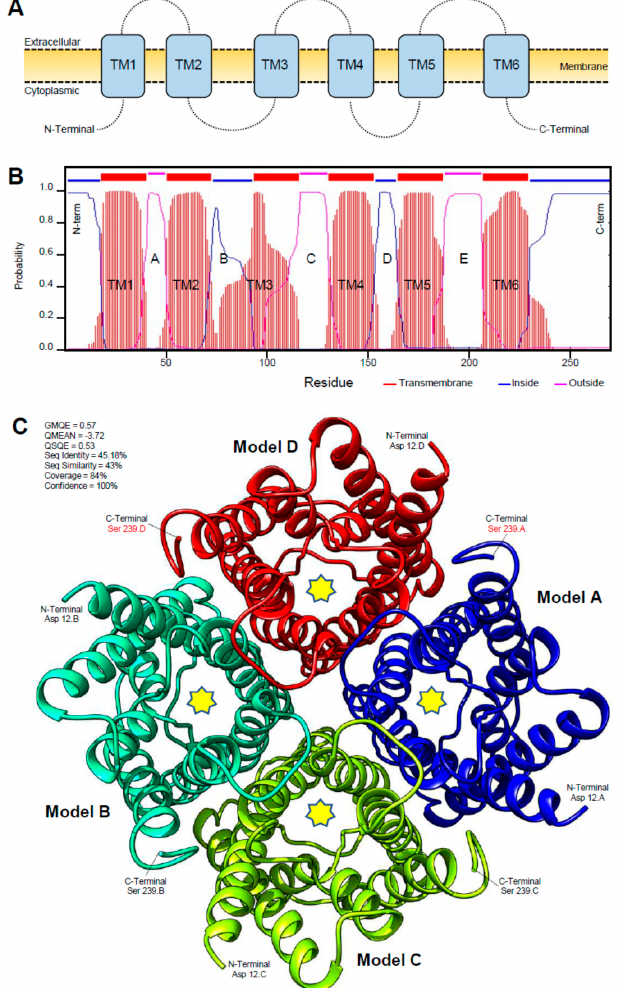
Figure 2. Protein characterization of aquaporin of D. citri. ( A , B ) Predicted membrane topology of DcAQP and domain architecture as predicted by TMHMM Server v. 2.0 and the Simple Modular Architecture Research Tool (SMART), respec- tively. ( C ) The predicted three-dimensional (3D) secondary model of DcAQP using a model from GENO 3D, which used crystallographic coordinates of Ratus norvegicus aquaporin 4 in the protein data bank (PDB ID: 2D57). Bioinformatic anal- yses were carried out using the available data of the official gene set (OGS-v2.0 proteins) for D. citri on the citrus greening solutions website (https://citrusgreening.org/organism/Diaphorina_citri/genome) and the available data on the GenBank, National Center for Biotechnology Information website (NCBI, https://www.ncbi.nlm.nih.gov/protein/ accessed on 16 September 2021).